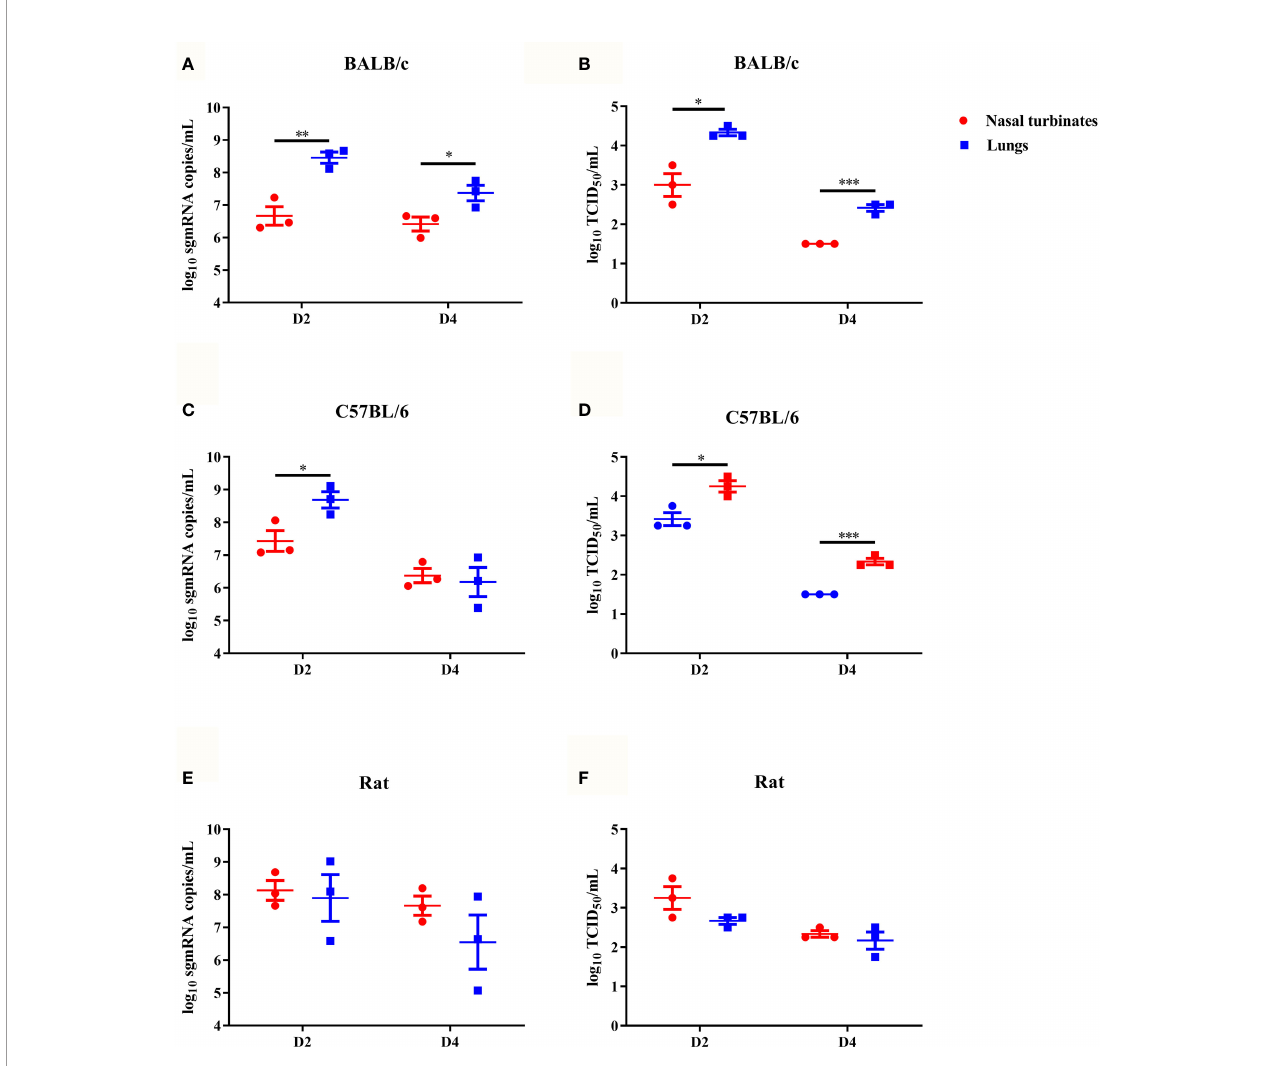
FIGURE 1 | The SARS-CoV-2 B.1.351 variant replicated ef fi ciently in mice and rats. The dotted line represents the detection limit. Viral subgenomic RNA (sgRNA) load (log 10 sgRNA copies/mL) in the nasal turbinates and lungs of inoculated female BALB/c mice (A) , female C57BL/6 mice (C) and male rats (E) . Viral titres (log 10 TCID 50 /mL) in the nasal turbinates and lungs of inoculated female BALB/c mice (B) , female C57BL/6 mice (D) and male rats (F) . All data are represented as the mean ± sem, and the number of replicate animals in each group was 3 (n=3). An unpaired t test was used to analyze the signi fi cant differences in viral titres and viral sgRNA loads between nasal turbinates and lungs (p<0.05,*; p<0.01,**;